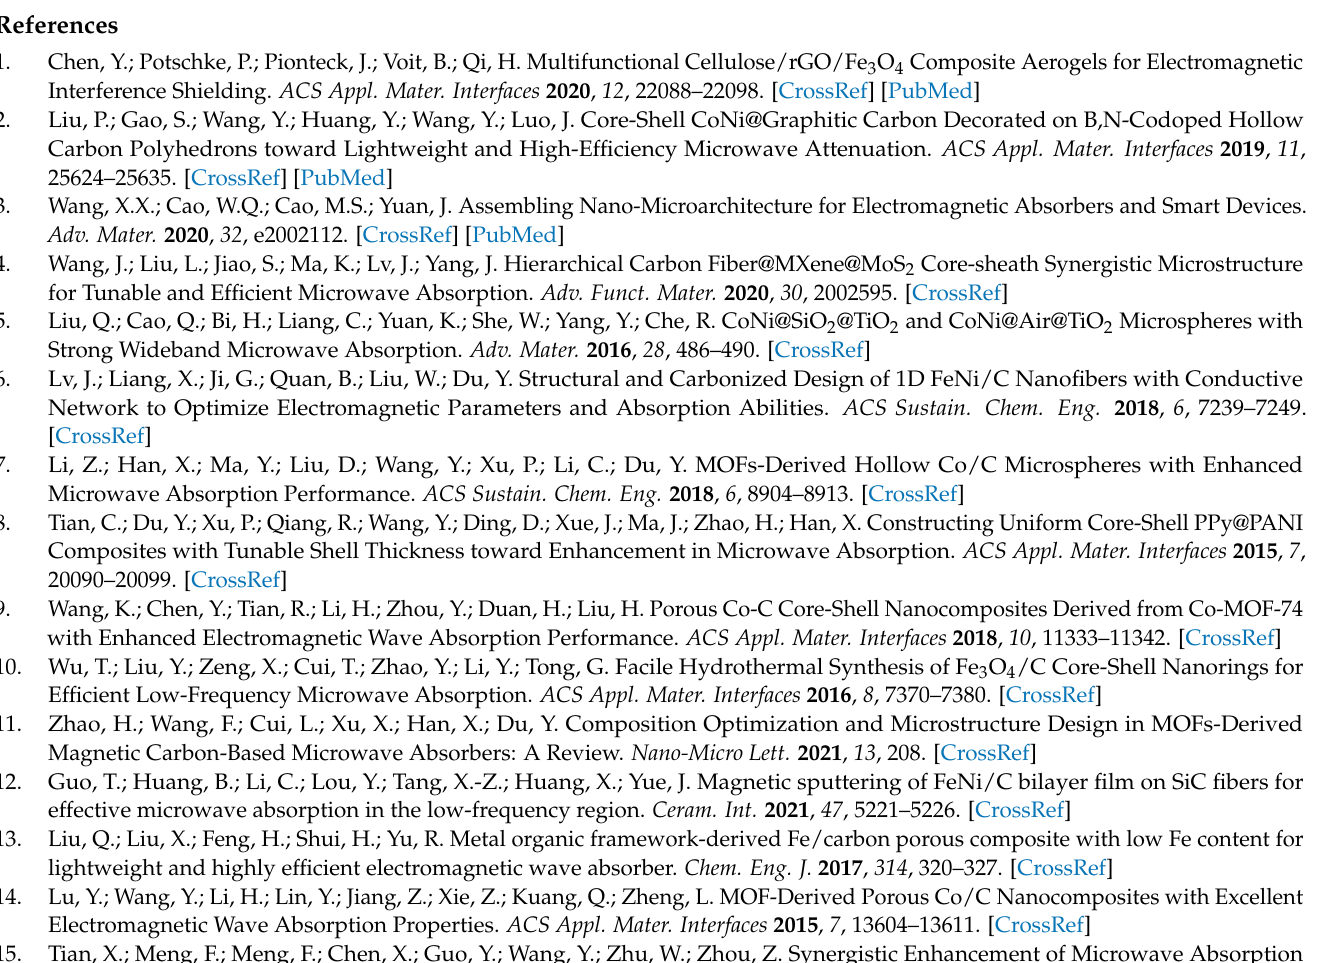
Figure S5: Real parts (a) and imaginary parts (b) of the complex permeability of DS-Mo 2 C/C-700, DS-Mo 2 C/C-800, and DS-Mo 2 C/C-900; Figure S6: The Cole-Cole semicircle of DS-Mo 2 C/C-700 (a), DS-Mo 2 C/C-800 (b), and DS-Mo 2 C/C-900